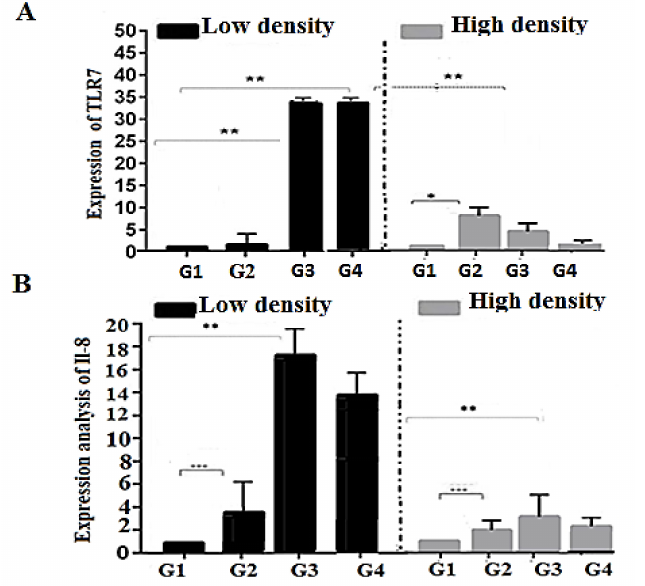
Figure 2. Relative expression of some immune response genes TLR-7 ( A ) and IL-8 ( B ) in Low and High stocking density of Nile tilapia ( Oreochromis niloticus ) with different treatment. All values are expressed as Mean ± SE. Asterisks on the data bars indicate when p < 0.05 (*), p < 0.005 (**), and p < 0.0005 (***). G1 (control without carbon source), G2 (treated with glycerol as a carbon source), G3 (treated with molasses as a carbon source), and G4 (treated with starch as a carbon